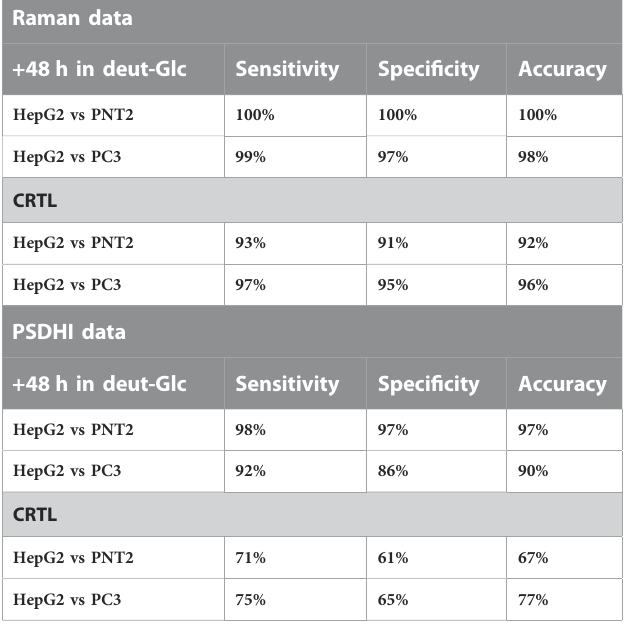
TABLE 1 PCA analysis on Raman data set and PSDHI data set comparing the classi fi cation sensitivity, speci fi city and accuracy for HepG2 vs PNT2 and HepG2 vs PC3 at 48 h in deut-Glc and for CRTL cells. Raman